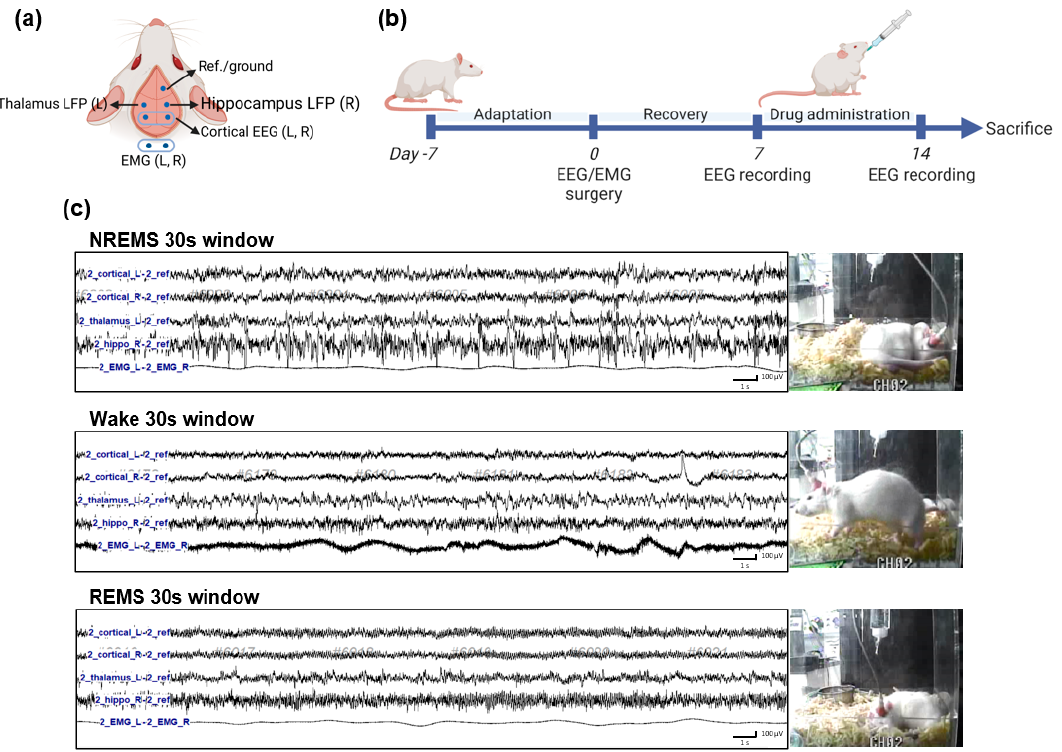
Figure 1. Schematic diagram of electrode placement for EEG/EMG recording and reference in the rat skull ( a ) and experimental design and timelines for the EEG/EMG recordings ( b ). Typical EEG/EMG waveforms are displayed for 30 s in each sleep state in rats ( c ). EEG, electroencephalogram;